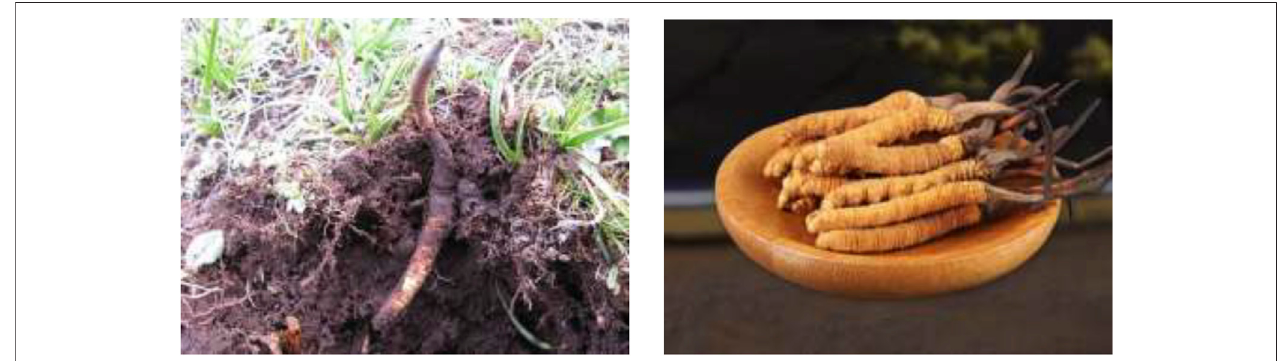
FIGURE 1 | Cordycepin sinensis in the soil (left). Traditional Chinese herb Dong Chong Xia Cao decoction pieces